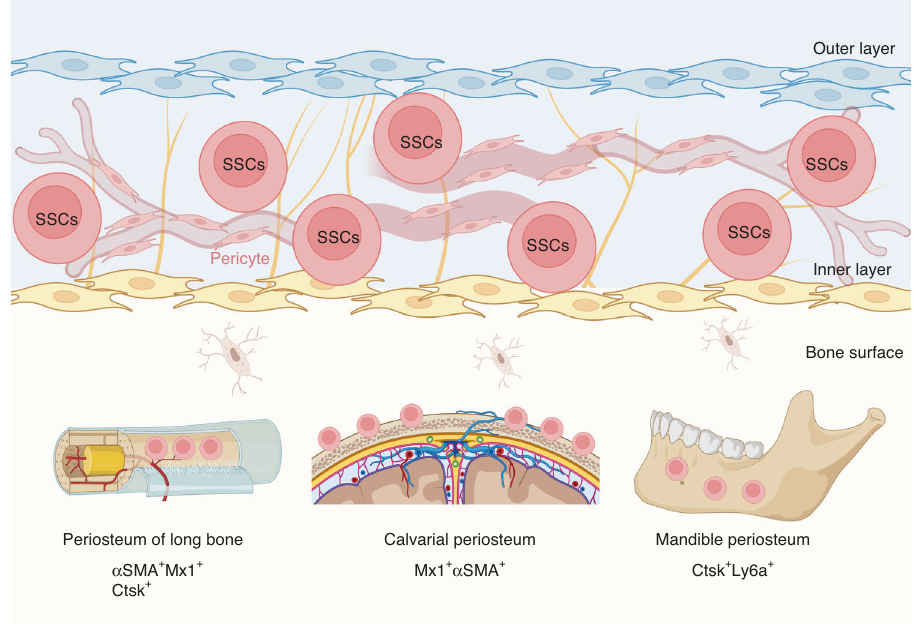
Fig. 3 Skeletal stem cells in periosteum. Periosteum of long bones, calvaria, and mandible harbors SSCs that participate in bone development and injury